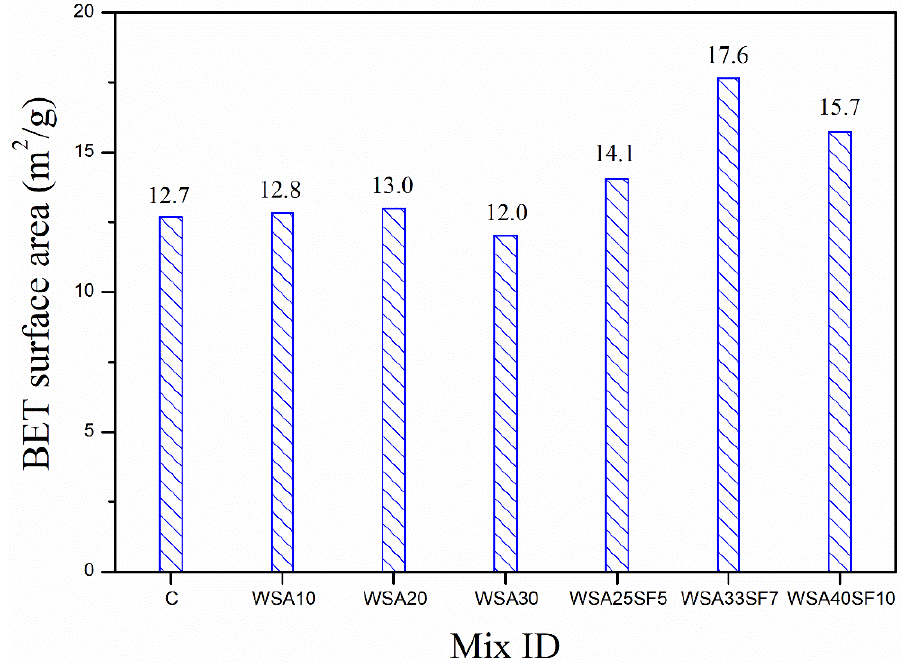
Figure 9. Comparison of BET surface area between control, binary (C/WSA) and ternary (C/WSA/SF) paste samples after 91 days of curing.